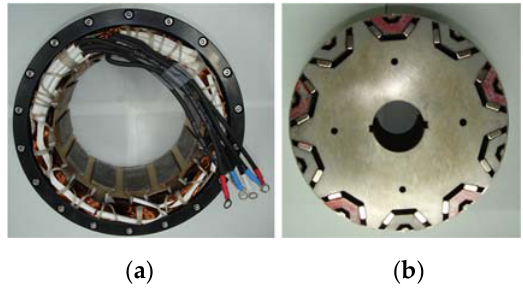
Figure 10. Manufactured motor; ( a ) Stator, ( b ) rotor.